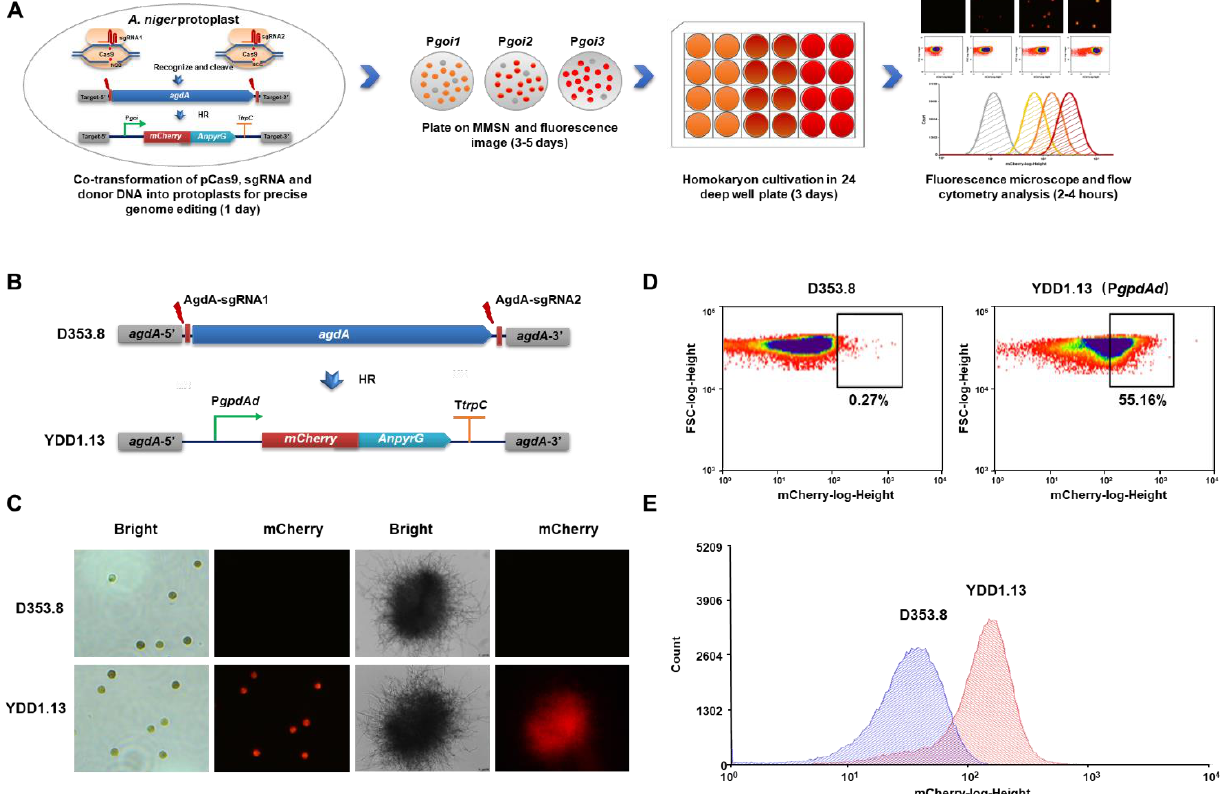
Figure 1. Fluorescent-auxotrophic selection coupled with CRISPR/Cas9 system and flow cytometry. ( A ) Schematic overview of a promoter evaluation workflow based on an intuitive fluorescent-auxotrophic selection. This workflow combined the efficient CRISPR/Cas9 genetic manipulation system, the fluorescent protein-selection marker fused indicator, and flow cytometry-based analysis. CRISPR/Cas9 system was applied for integration of the reporter at the specific genome locus. Then, transformants with distinct fluorescence were picked in 24-deep-well plates based on fluorescence imaging. After genotype verification, fluorescence intensity was detected by laser scanning confocal microscope and flow cytometry. ( B ) Schematic diagram of mCherry-pyrG- expressing construct un- der the control of the P gpdAd promoter. The donor DNAs comprised the PgpdAd:: mCherry-pyrG cassette, and 40-bp micro-homology arms targeted the flanking sequences of agdA gene. After being constructed, the donor DNAs were co-transformed with linear sgRNA constructs ( agdA -sgRNA1 and agdA -sgRNA2) and the Cas9 expression cassette into protoplasts of the kusA and pyrG deficient chassis D353.8. Two DNA double-strand breaks (DSBs) at the flanking sequences of the agdA gene were generated by the Cas9 under the guide of two sgRNAs and then were repaired by homologous recombination (HR) with the integration of the donor DNAs, resulting in YDD1.13. ( C ) Representa- tive fluorescence images in conidia and mycelial pellets of YDD1.13-expressing mCherry-pyrG with the P gpdAd promoter. The parent strain D353.8 was used as negative control. ( D , E ) Flow cytometry analysis of the conidia of YDD1.13. The 100,000 spores were analyzed by flow cytometry. Black boxes marking the same value of mCherry-log-height were used for direct comparison of YDD1.13 with the parent strain D353.8. 3.2. Evaluation of Endogenous Constitutive Promoters Using the Fluorescent-Auxotrophic Selection Workflow To seek strong promoters, we selected six native promoters involved in the central metabolism in A. niger and assessed their strength with the above-established method. The native promoters included glyceraldehyde-3-phosphate dehydrogenase promoter (P gpdAg ), enolase promoter (P enoA ), pyruvate kinase promoter (P pkiA ) [38], citrate syn- thase promoter (P citA ) [39], malate dehydrogenase promoter (P mdhA ) [15], and constitu- tive transcription factor (P mbfA ) [15]. To avoid the influence of an integration site, all the